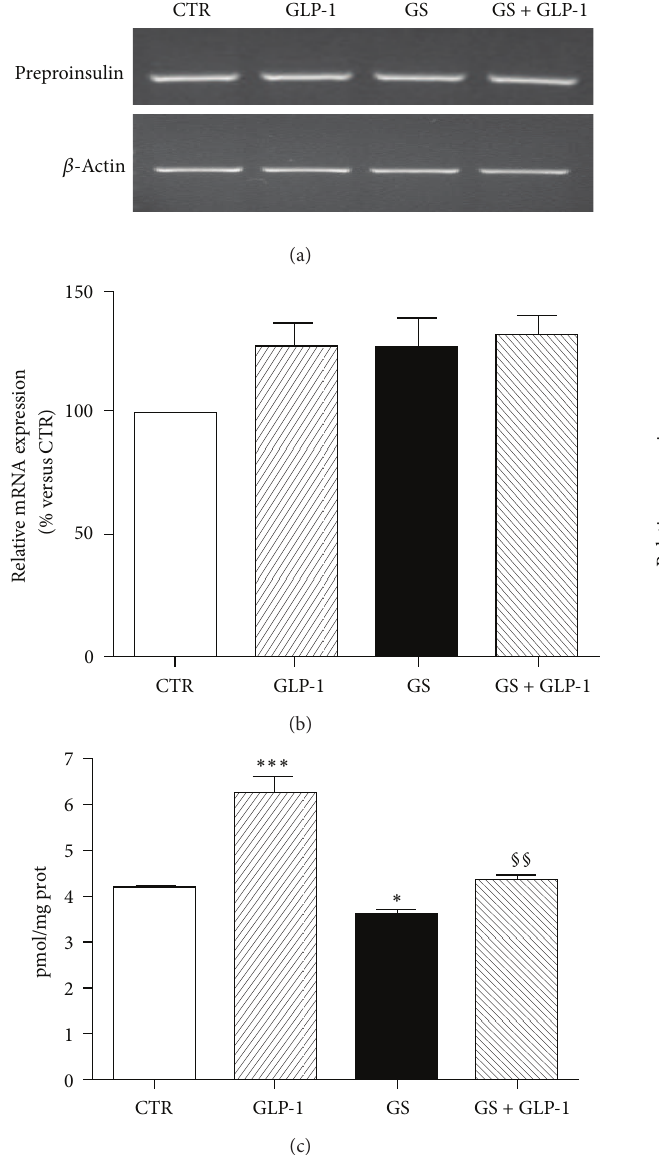
Figure 9: GLP-1R downregulation in HIT-T15 cells. HIT-T15 cells weretransfectedwithspecificsiRNAforGLP-1R(GLP-1R-siRNA)or a random sequence (scrambled-siRNA). (a) Expression of GLP-1R was analyzed 48 hours and 7 days after transfection. (b) Transfection of HIT-T15 cells with GLP-1R siRNA results in more than 50% knockdown of GLP-1R expression. (c) Five days after treatment with GS, cells were lysed and immunoblotted with specific antibodies against MafA, PDX-1, and 𝛽 -actin proteins. Blots are representative of three independent experiments. ∗ 𝑃 < 0.05 and ∗∗∗ 𝑃 < 0.001 versus scrambled